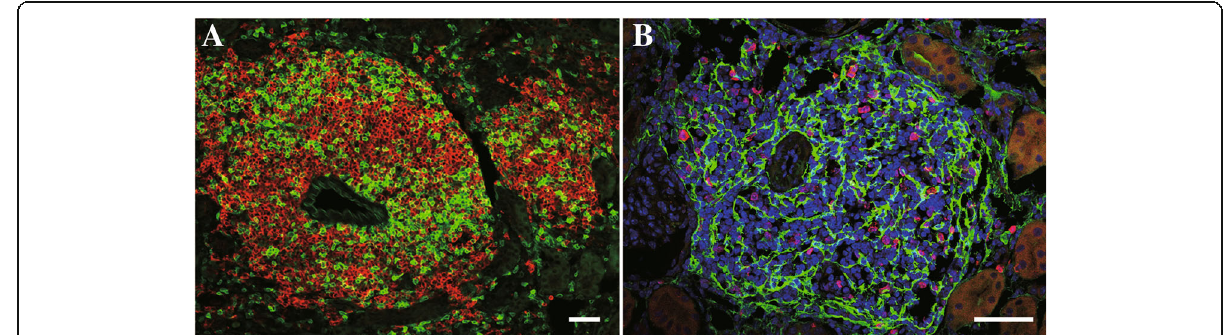
Fig. 1 Tertiary lymphoid tissues in aged injured mouse kidney. Tertiary lymphoid tissues are mainly composed of T cells and B cells, some of which are proliferating. p75NTR-positive fibroblasts extend their projections and form a structural backbone within TLTs. a green : CD3 ε , red : B220.